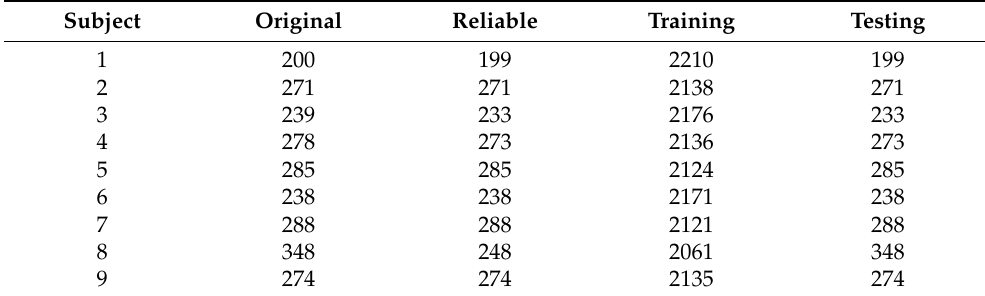
Table 2. Number of original samples, number of samples considered reliable after pre-processing and data division for the leave-one-subject-out cross-validation procedure.